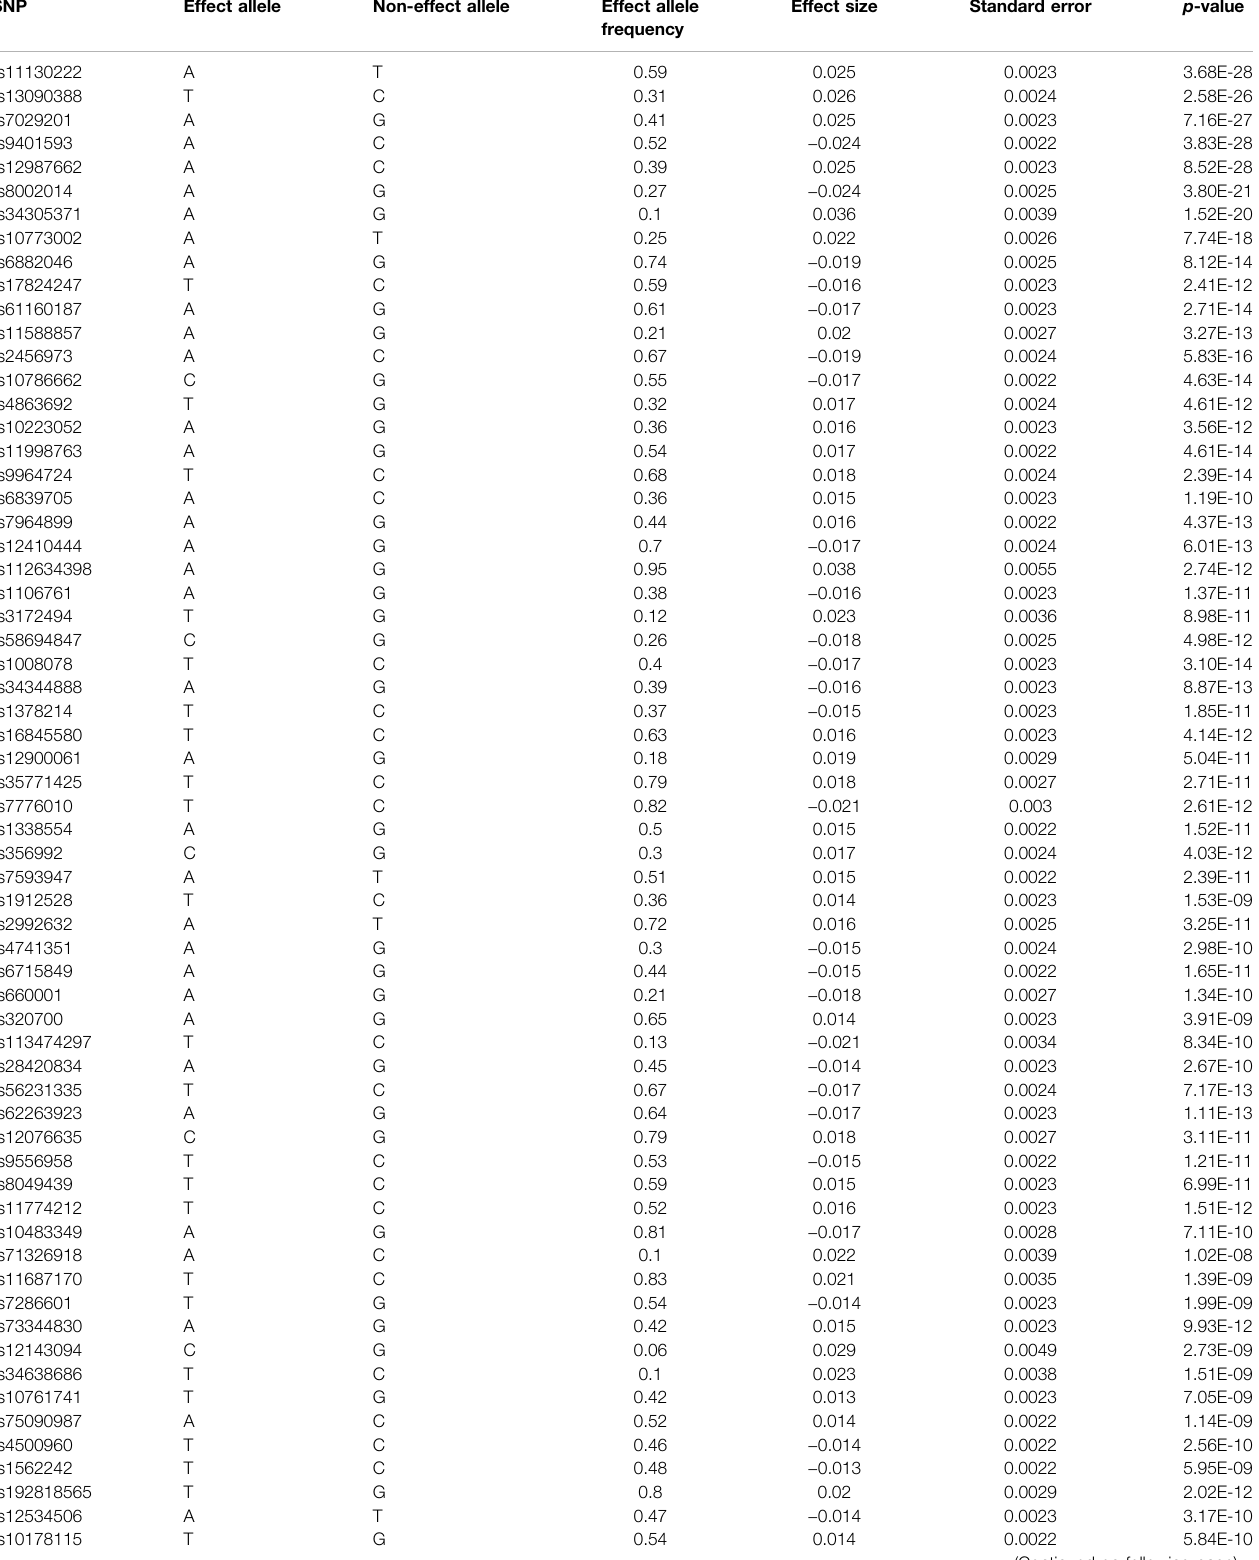
TABLE 1 | 162 independent genetic variants as the potential instrumental